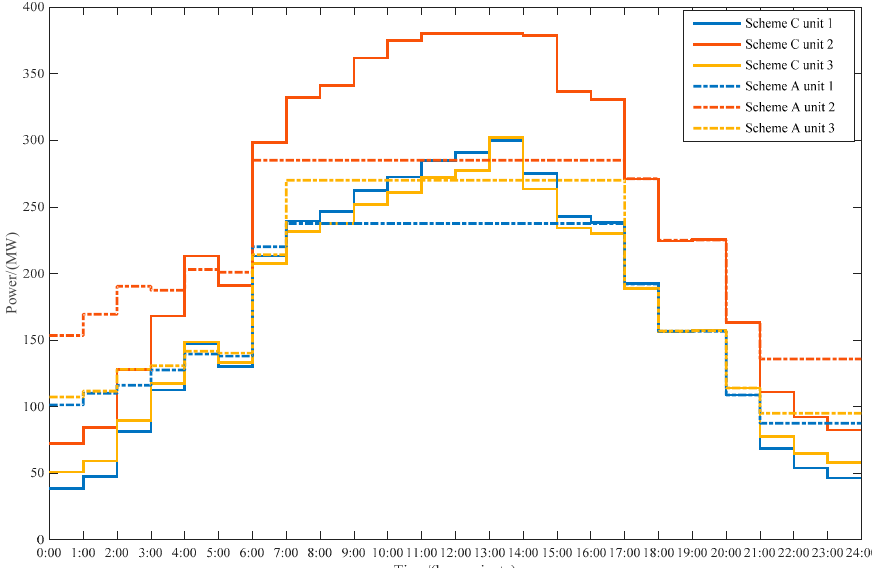
Figure.9. Thermal generator power outputs in the day-ahead scheduling of schemes A and C.